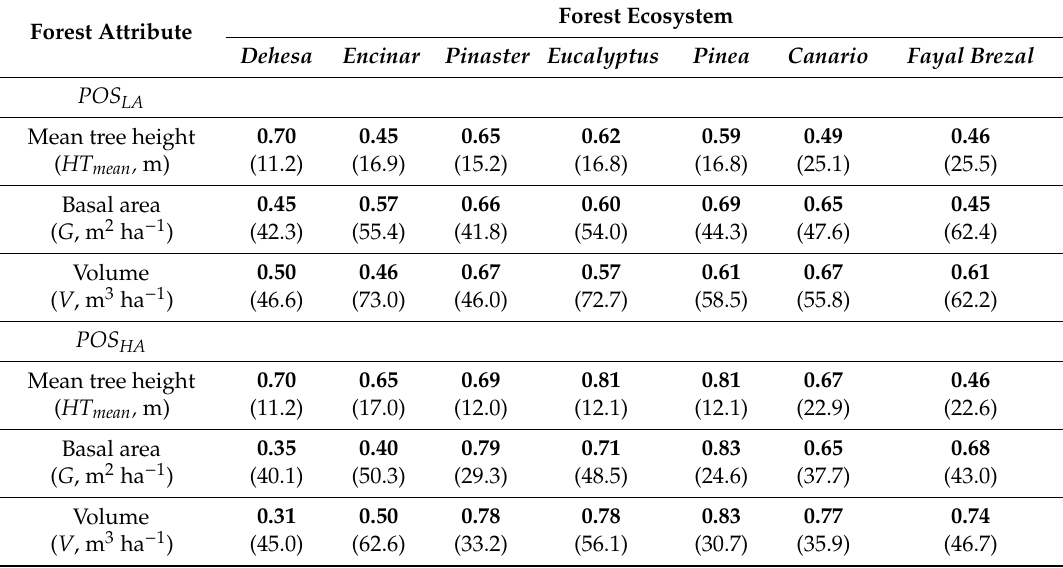
Table 6. Goodness of the model fitting expressed by the R-squared value in bold and the computed RMSE% between parentheses. The results are presented for seven forest ecosystems considering low- accuracy positioning methods ( POS LA ) and commercial-grade GNSS positioning ( POS HA ). Forest Ecosystem Forest Attribute Dehesa Encinar Pinaster Eucalyptus Pinea Canario Fayal